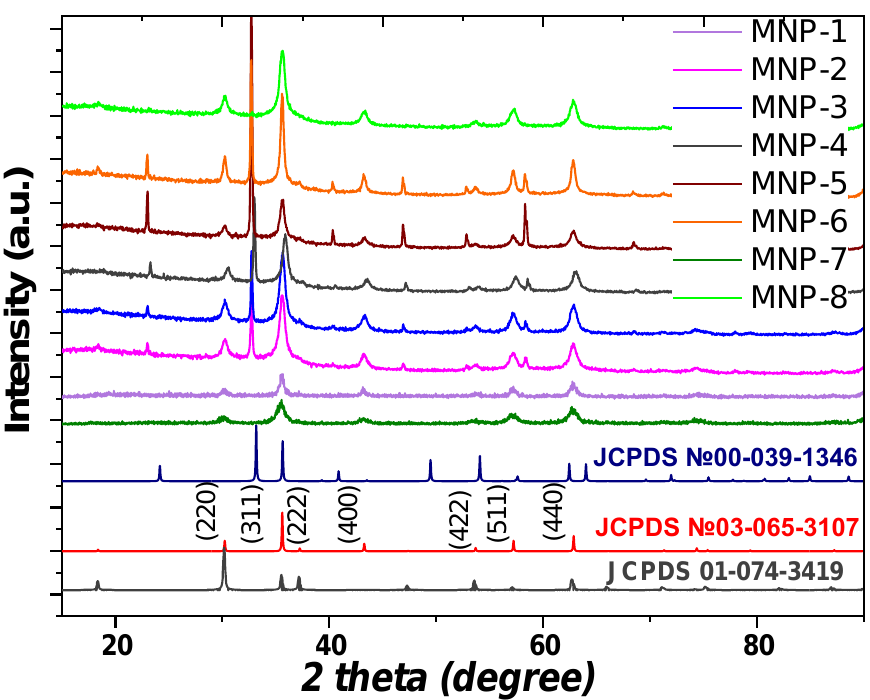
Figure 5. Powder XRD patterns of obtained MNPs using ethanolic extract of Artemisia tilesii and reference materials (magnetite, maghemite and cobalt ferrite).